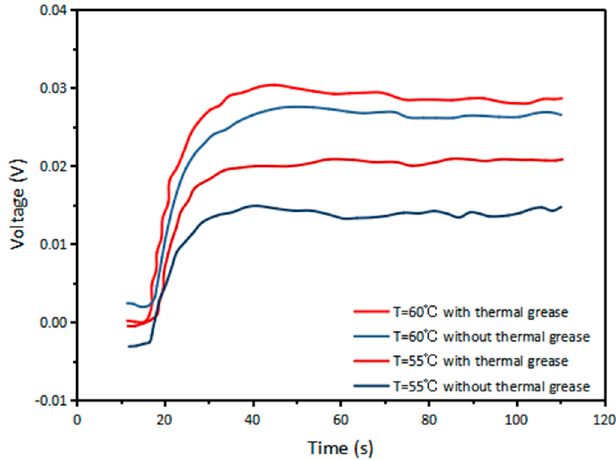
Figure 4. Open circuit voltages of TEG with and without thermal grease attached on the cold side.